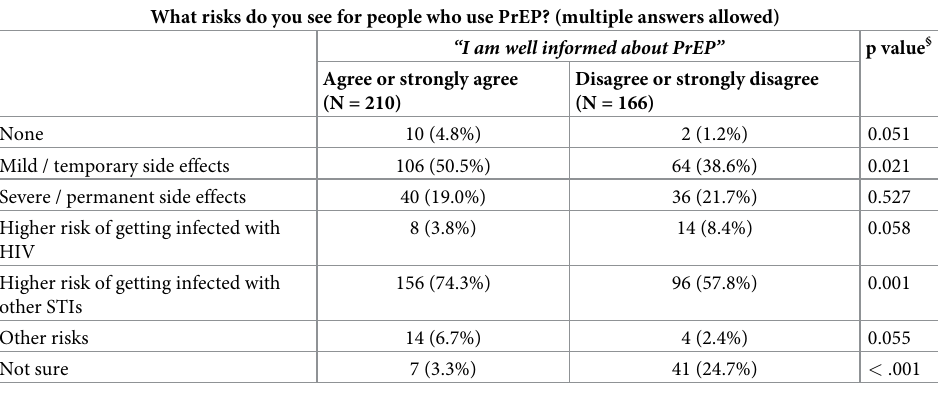
Table 3. Participants’ perception of risks of PrEP use, by self-reported level of knowledge about PrEP. What risks do you see for people who use PrEP? (multiple answers allowed) “I am well informed about PrEP” p value § Agree or strongly agree Disagree or strongly disagree (N = 210) (N = 166) None 10 (4.8%) 2 (1.2%) 0.051 Mild / temporary side effects 106 (50.5%) 64 (38.6%) 0.021 Severe / permanent side effects 40 (19.0%) 36 (21.7%) 0.527 Higher risk of getting infected with 8 (3.8%) 14 (8.4%) 0.058 HIV Higher risk of getting infected with 156 (74.3%) 96 (57.8%) 0.001 other STIs Other risks 14 (6.7%) 4 (2.4%) 0.055 Not sure 7 (3.3%) 41 (24.7%) < .001 STI, sexually transmitted infection. § From Chi-squared tests of the null hypothesis that there is a no significant difference between the expected frequencies and the observed frequencies in the